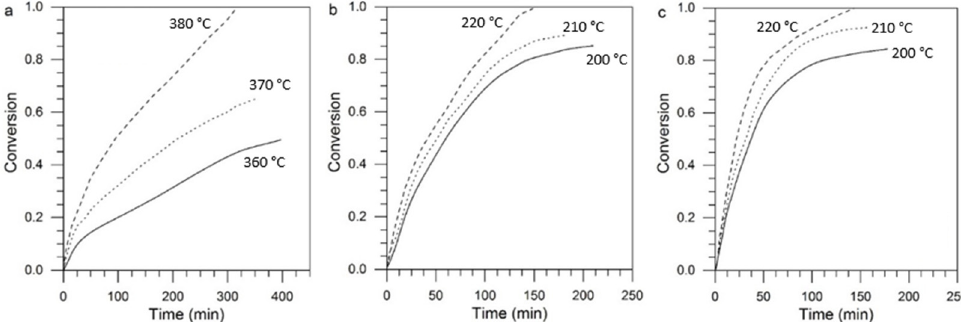
Figure 8. Isothermal conversion ( α ) for steam gasification of ( a ) n -C 7 asphaltenes in the absence (360 ◦ C, 370 ◦ C, and 380 ◦ C) and presence (200 ◦ C, 210 ◦ C, and 220 ◦ C) of ( b ) AlNi1 and ( c ) AlNi1Pd1